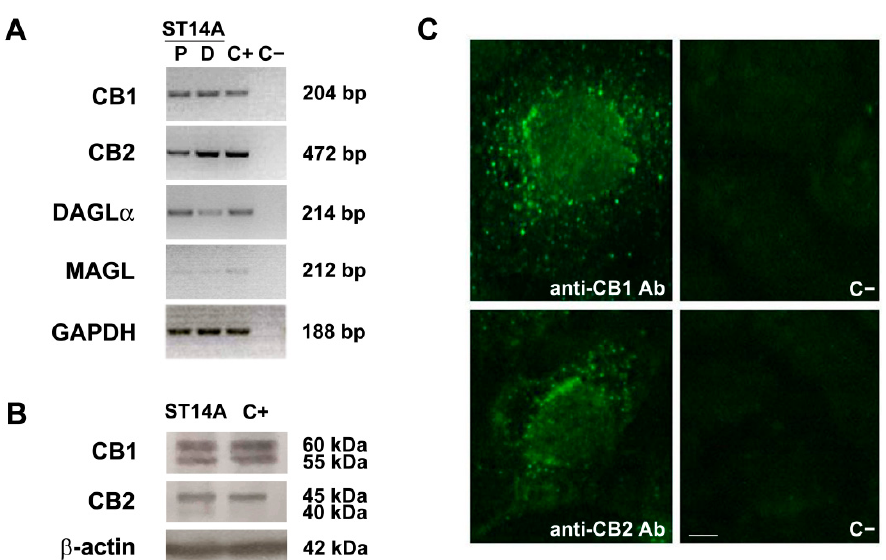
Figure 1. Endocannabinoid system expression in ST14A neural progenitor cells. ( A ) RT-PCR revealed specific bands corresponding to CB1 and CB2 receptors and to the enzymes DAGL α and MAGL in ST14A cells cultured 48 h under proliferating conditions (P). The same genes were also expressed in ST14A cells induced to differentiate toward a neuronal phenotype for 72 h (D, differentiating conditions). The housekeeping gene GAPDH was used as reference gene. The base pair (bp) length of the different amplicons is indicated. C+: positive controls, i.e., cDNA from rat brain or from rat spleen (for CB2 only); C − : negative control (no RT). ( B ) Western blot showing the expression of CB1 and CB2 receptors in ST14A neural progenitors (cells cultured 48 h under proliferating conditions); β -actin protein expression was used as a quality control of the protein extract. The apparent molecular weights of the bands are indicated (kDa). C+: positive controls, i.e., protein extracts from rat brain or spleen (for CB2 only). ( C ) Immunofluorescence for CB1 and CB2 receptors in ST14A cells neural progenitors (cells cultured 48 h under proliferating conditions). Single-cell magnification. Specific immunoreactivities are mainly distributed in the cytoplasm and in proximity to the nucleus. C − : negative controls, i.e., anti-CB1 or anti-CB2 pre-adsorbed antibod- ies. Calibration bar: 5 µm.